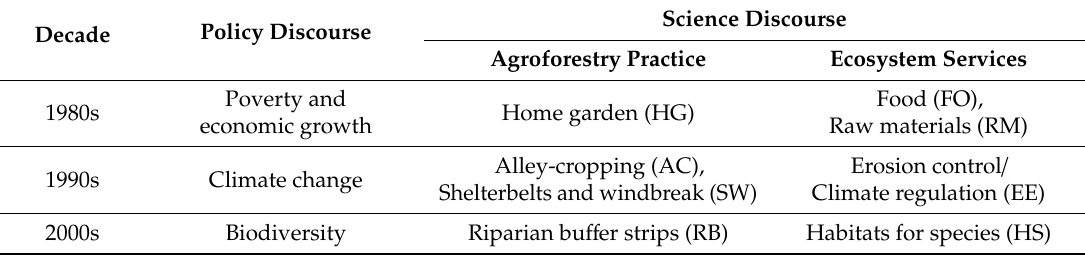
Table 4. The change of forest policy discourse and science discourse on agroforestry practices and ecosystem services in the Asia-Pacific region